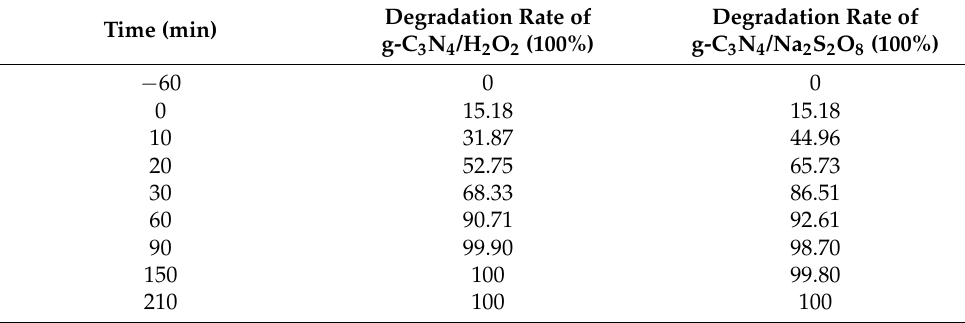
Table 2. Degradation rate of MO in synergistic systems. Time